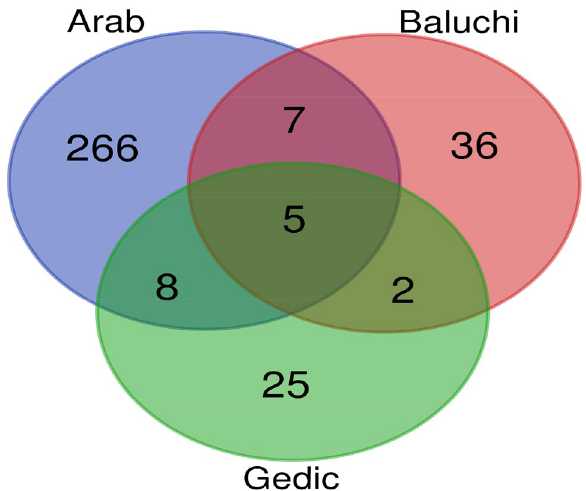
Figure 3. Venn diagram representing common and unique CNVRs found among the three Afghan sheep breeds. This figure was created using VENN diagram web tool (https:// bioin forma tics. psb. ugent. be/ webto ols/